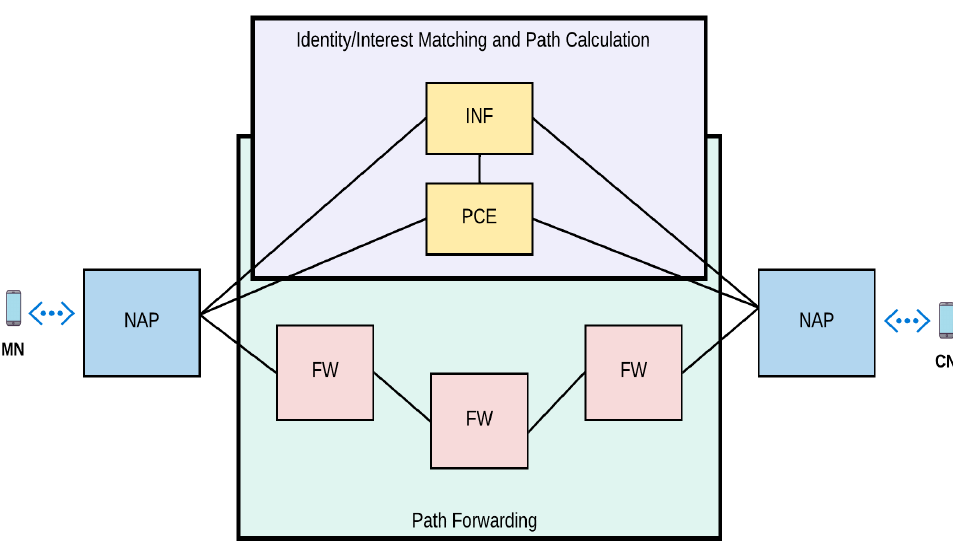
Figure 4. Path Forwarding